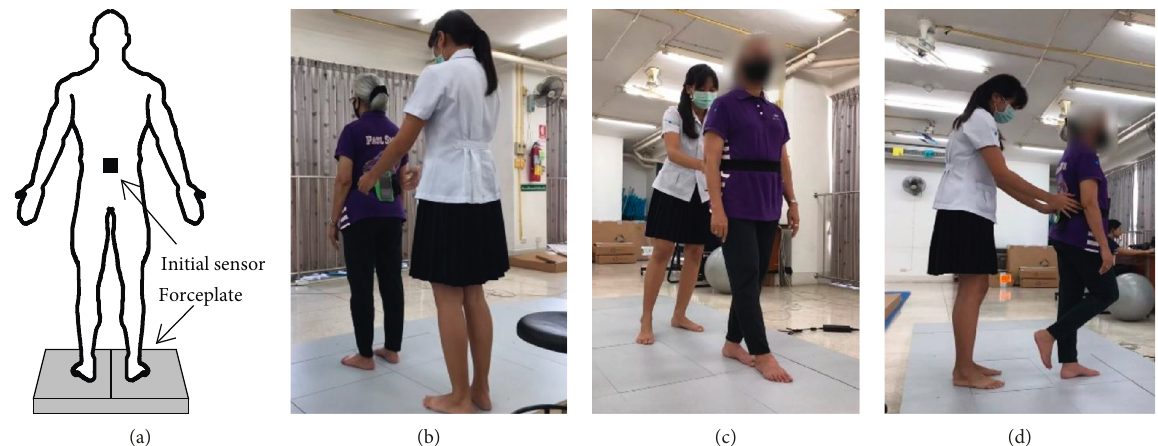
Figure 1: Protocols of the experiment in this study: (a) position of a sensor and force plate; (b)–(d) test conditions during 3 different protocols; double stance standing, standing in tandem, and single-leg stance, respectively.